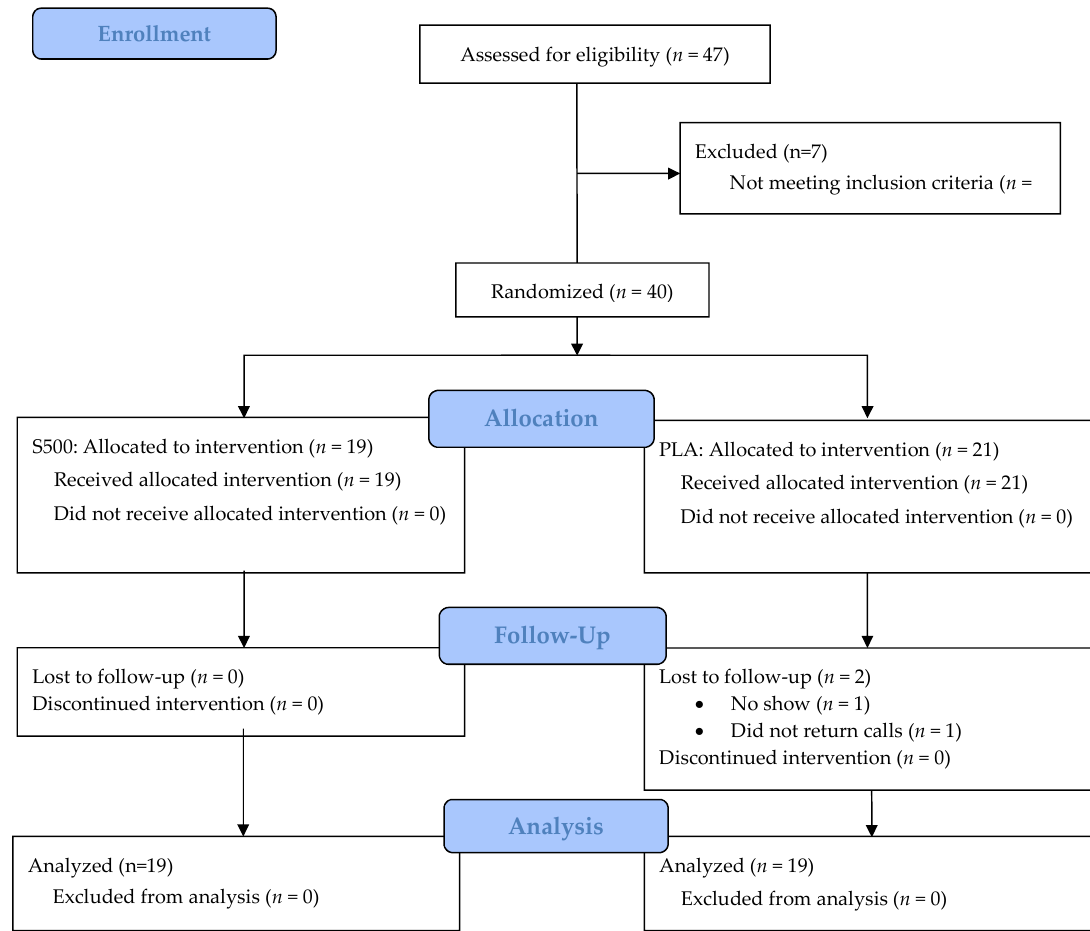
Figure 1. Consolidated Standards of Reporting Trials (CONSORT)